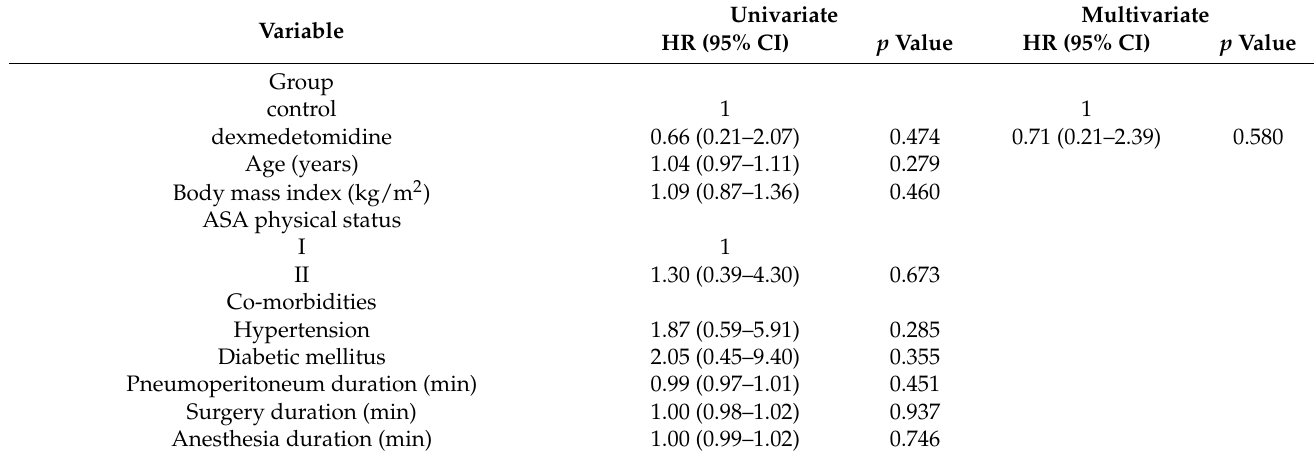
Table 4. Univariate and multivariate analyses of risk factors for radiographic progression after RALP ( n =